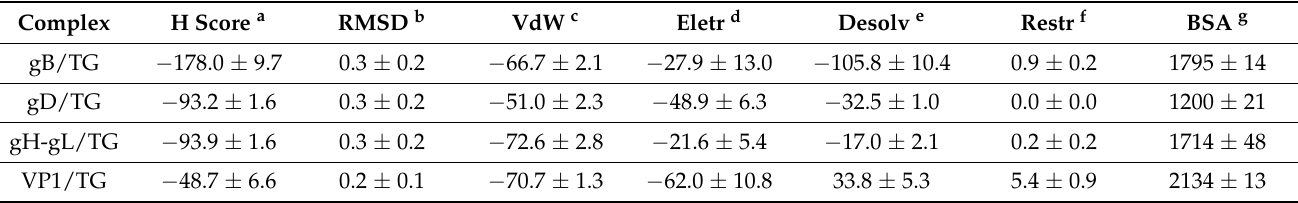
Table 1. Lowest energy pose HADDOCK refinement outputs.